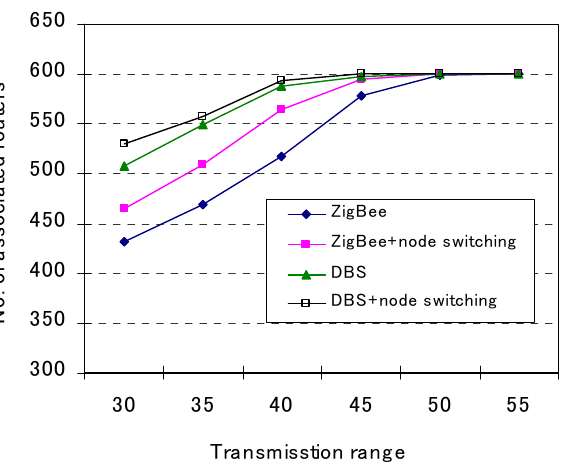
Figure 10. Number of associated router devices over transmission